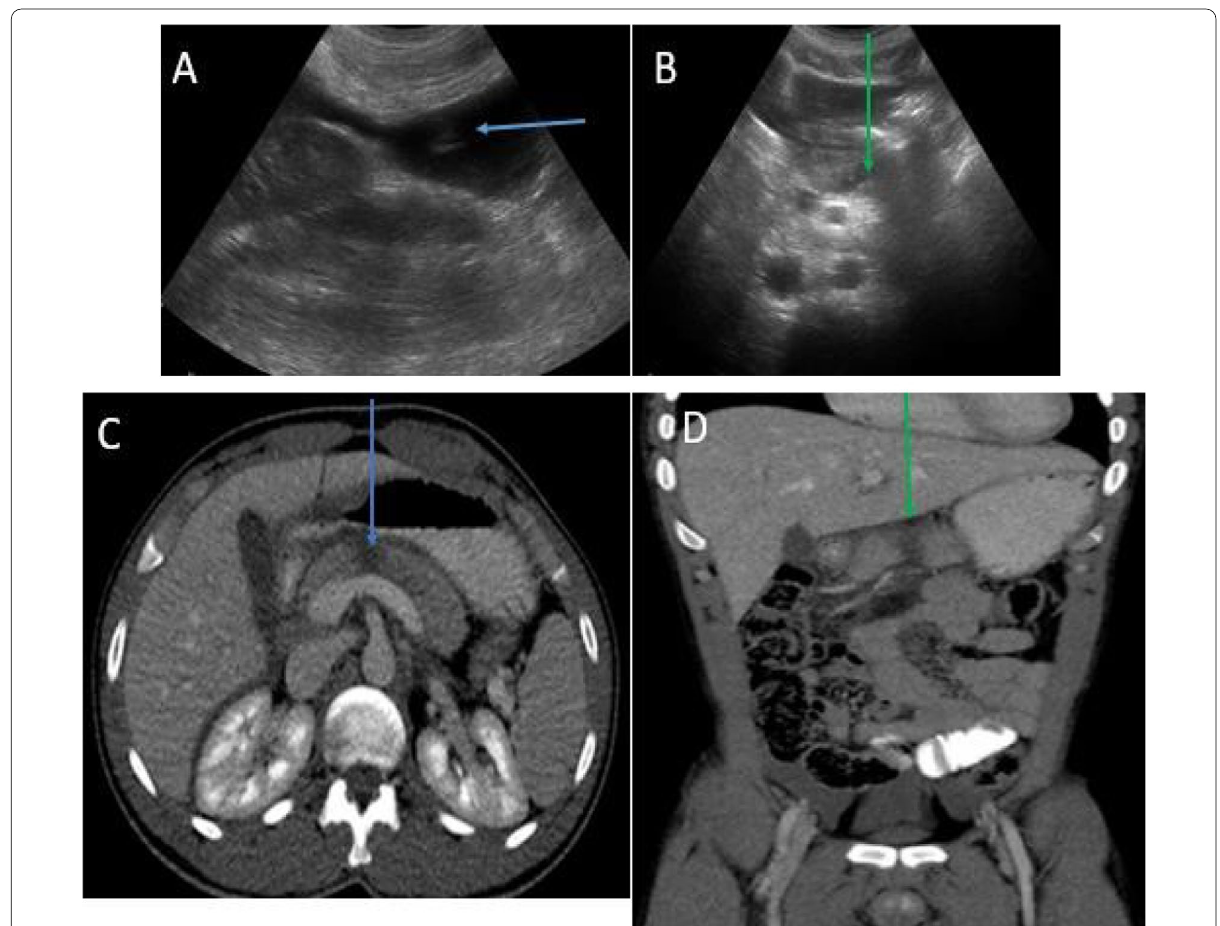
Fig. 4 A 40‑year‑old male patient presented with a fall from height with epigastric pain. A FAST examination: mild Intra peritoneal fluid (blue arrow) with no definite solid organ injury. B Serial FAST of the same patient: hypo‑dense line traversing the body of pancreas (green arrow). Contrast‑enhanced MDCT: C axial portal phase image showing a hypo‑dense line traversing the body of pancreas with involvement of the pancreatic duct and sparing of the pancreatic head (grade IV laceration, blue arrow). D Coronal portal phase image: showing a hypodense line traversing the body of pancreas (green